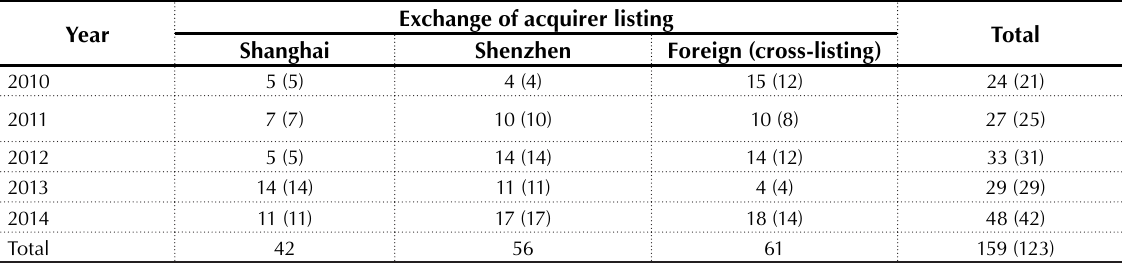
Table 1. Trends in cross-border deals announced by listed Chinese